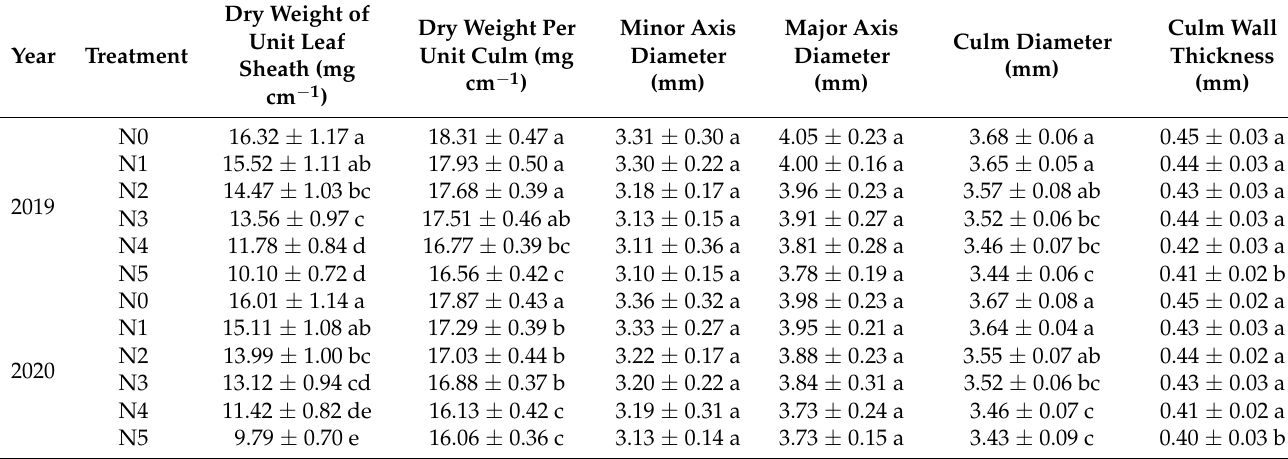
Table 5. Effects of N application rate on morphological characteristics of the S2 basal internode of rice under dry cultivation in 2019 and